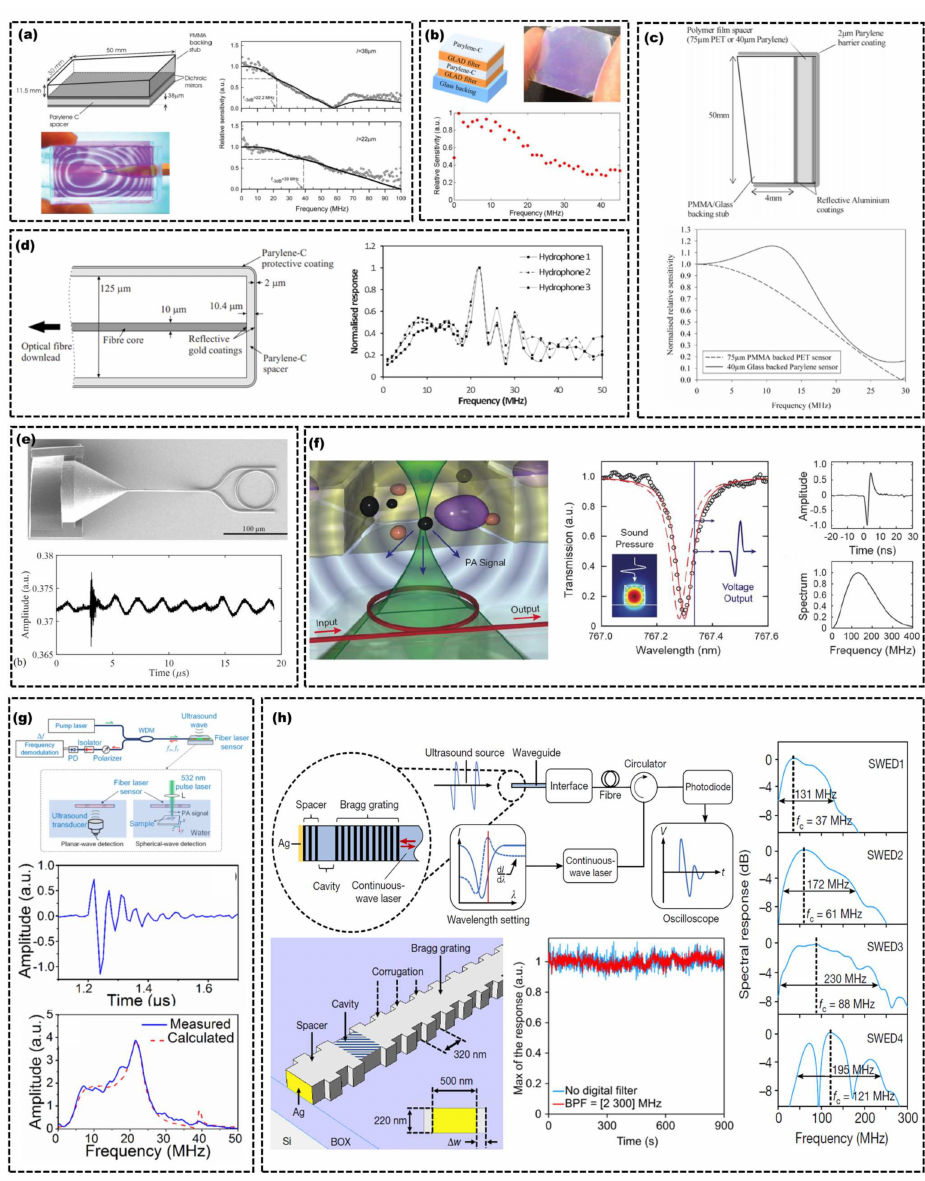
Figure 1. ( a ) Schematic of FP sensor head (upper left), photograph of sensor head (lower left), and FP sensor frequency response (right). Adapted with permission from ref. [42]. Copyright 2008 Optical Society of America; ( b ) The configuration of FP interferometers (upper left), the glancing angle deposited nanostructured film (GLAD) FP US sensor (upper right), GLAD- FP US sensor frequency response (bottom). Adapted with permission from ref. [51]. Copyright 2013 Optical Society of America; ( c ) Schematic of FP US sensor head (top), predicted normalized frequency response characteristics of 40 µ m parylene and 75 µ m PET sensors (bottom). PET: Polyethylene terephthalate, PMMA: polymethylmethacrylate. Adapted with permission from ref. [52]. Copyright 2005 Institute of Electrical and Electronics Engineers; ( d ) Schematic of the FPI sensing structure deposited at